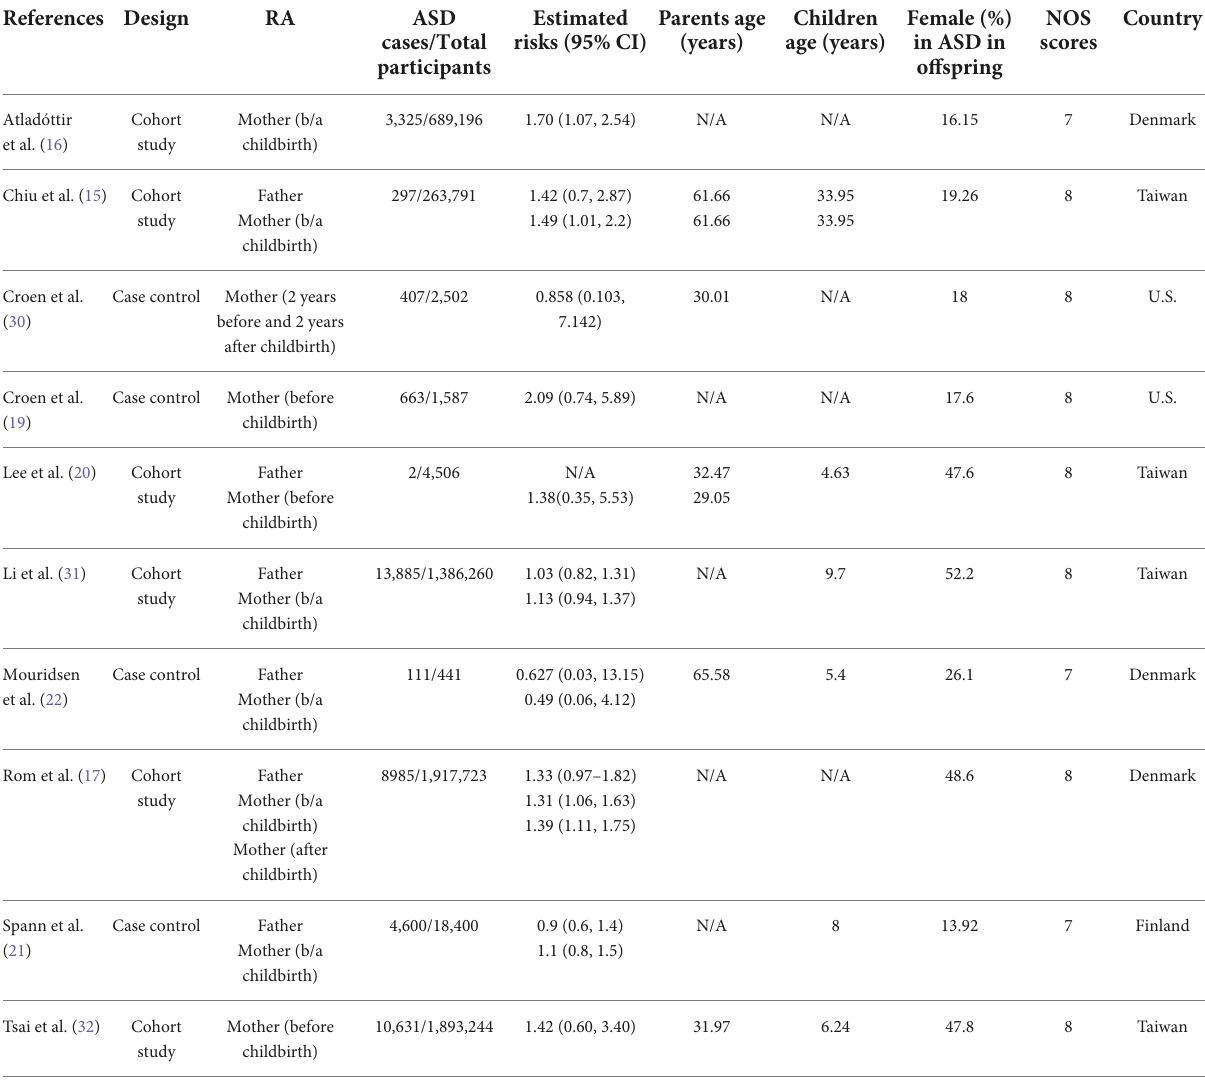
TABLE 1 Summary of characteristics of included studies in the current meta-analysis ( n =